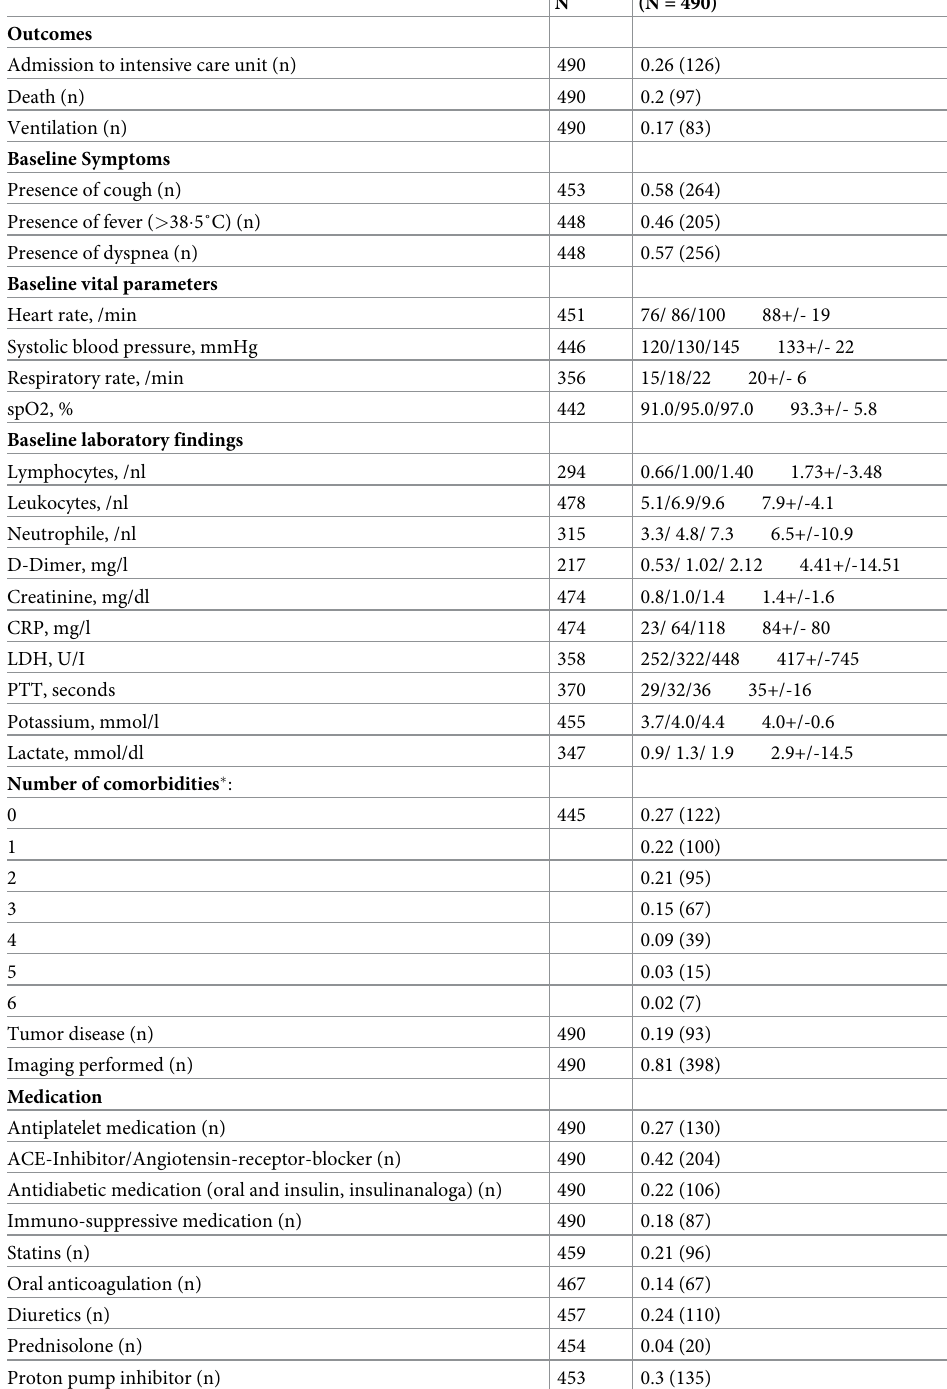
Table 4. Baseline characteristics and baseline symptoms of cohort Hamburg/Gauting (n = 490).